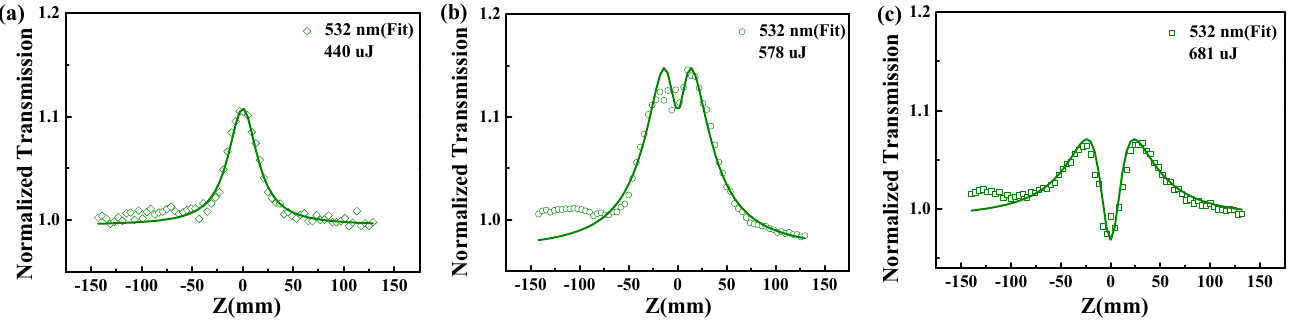
Figure 2. Open aperture Z-scan is conducted at the wavelength of 532 nm and the laser energies at ( a ) 440 μ J, ( b ) 578 μ J and ( c ) 681 μ J to obtain the normalized transmission of V 2 CT X hybrid colloid.